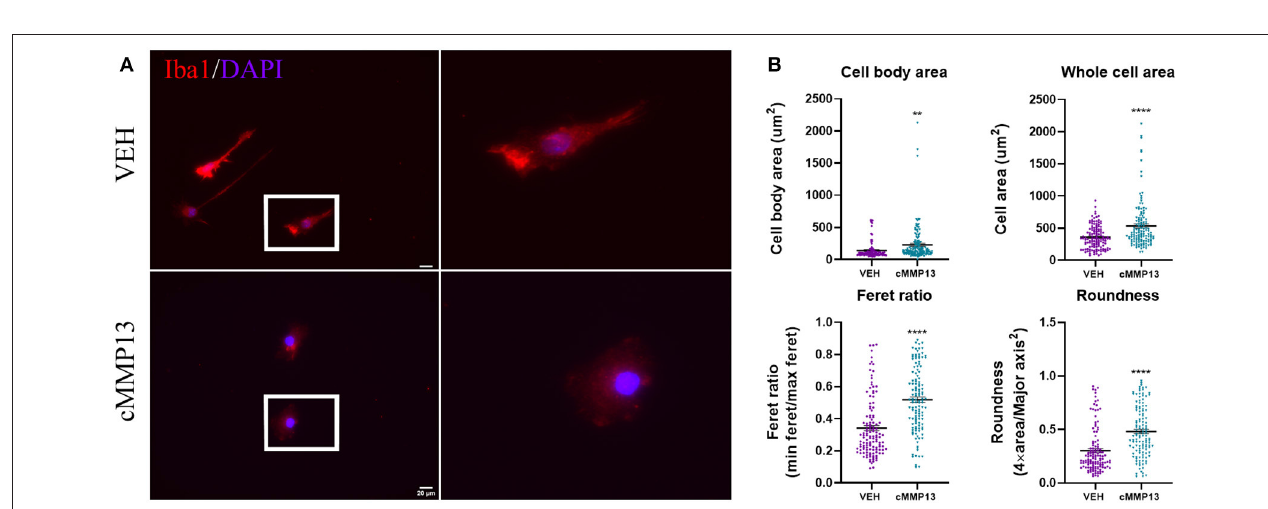
FIGURE 7 | cMMP13-stimulated microglia exhibit an amoeboid morphology. (A) Microglia were stimulated with 20nM cMMP13 for 24h and subsequently evaluated for morphological changes using Iba1 immunocytochemistry (red). Nuclei were counterstained with DAPI (blue). (B) Cell body area, whole cell area, Feret ratio, and roundness were quantified using ImageJ analyses. cMMP13 exposure changed the morphological parameters indicative of a switch from a rod-like (vehicle treatment) to amoeboid morphology, n = 127 cells for both cMMP13 and VEH. Values are reported as mean ± SEM, using an unpaired Student’s t -test; ** P ≤ 0.01 and **** P ≤